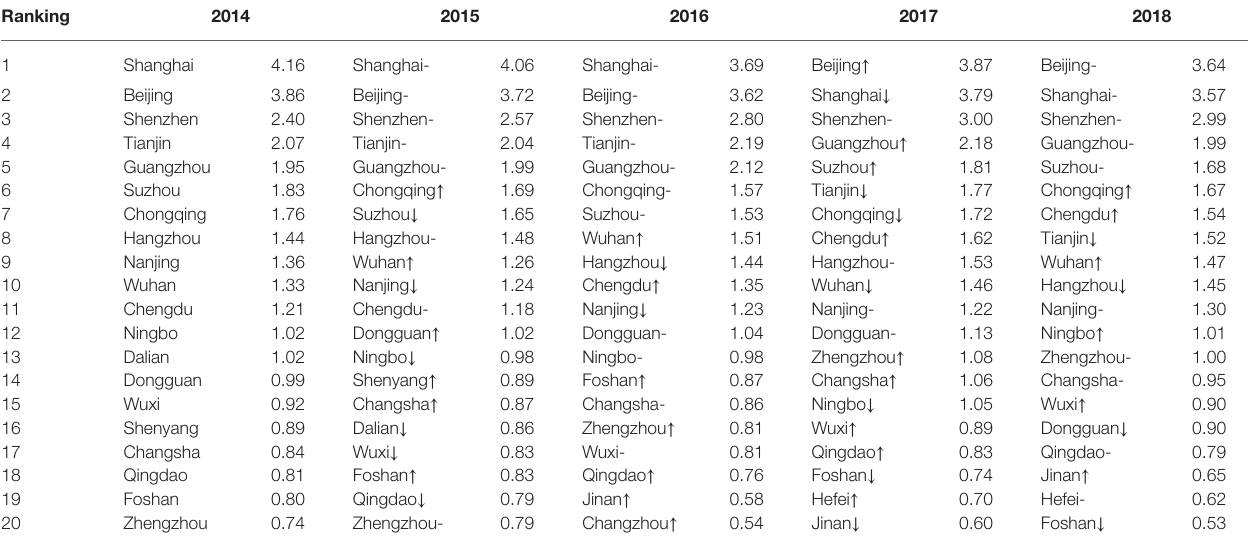
TABLE 5 | City business environment evaluation